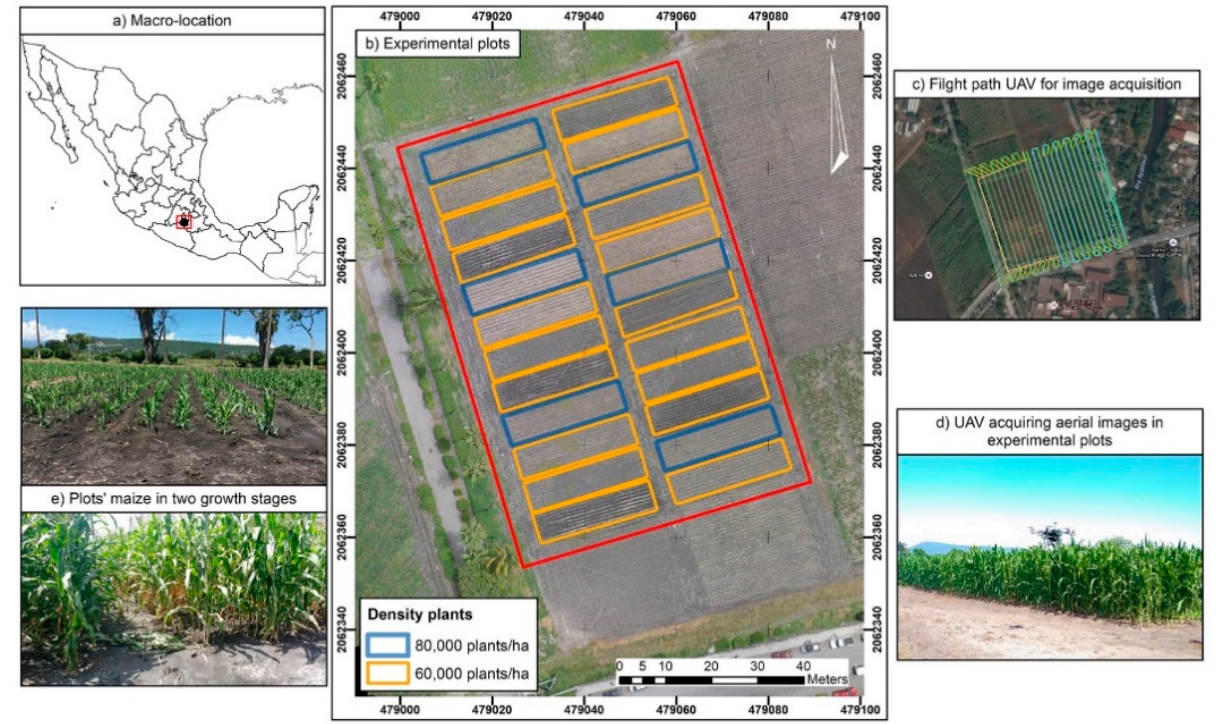
Figure 1. Location of the study area: ( a ) macro-location, ( b ) experimental plots, ( c ) flight path of Unmanned Aerial Vehicles (UAV), ( d ) UAV acquiring aerial images, ( e ) plots’ maize in two growth stages.